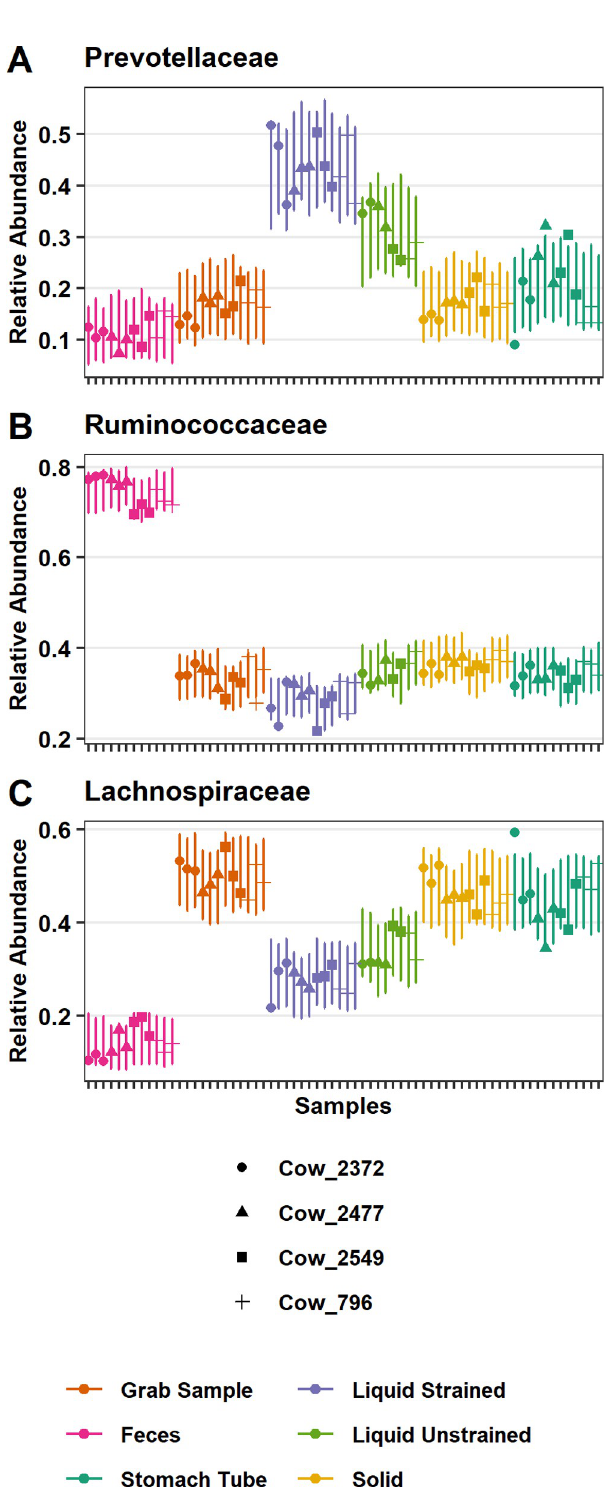
Fig 5. Significant differences in the relative abundance of specific bacterial families. Relative abundance of (A) Prevotellaceae (B) Ruminococcaceae and (C) Lachnospiraceae as modeled by corncob. Points are the estimated relative abundance and bars are a 95% prediction interval for each cow on different days of sampling.